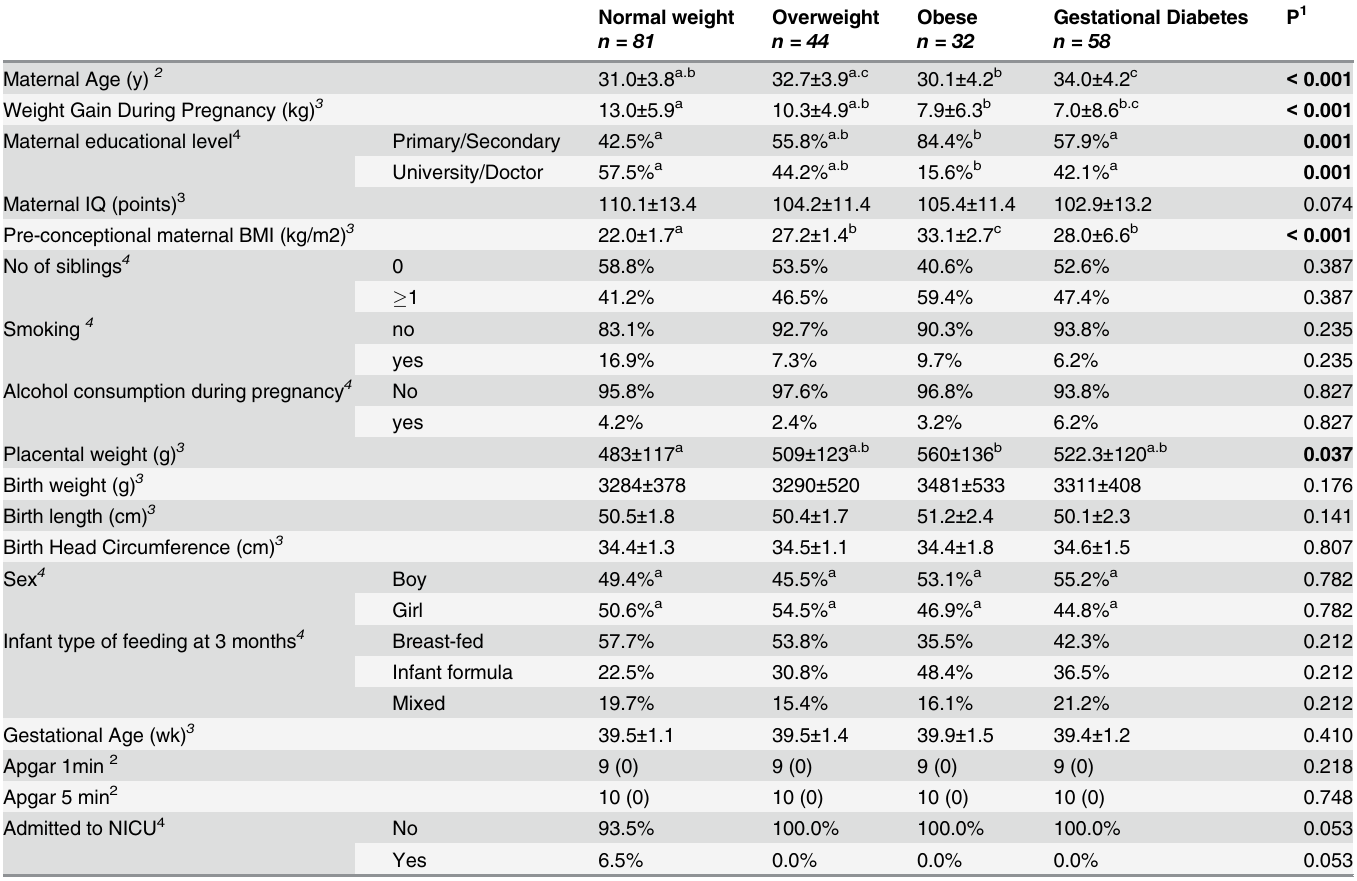
Table 1. Baseline and background characteristics of the mother-child pairs who participated in the neurodevelopmental follow up at 6 months of age (n = 215), including group comparisons among the four